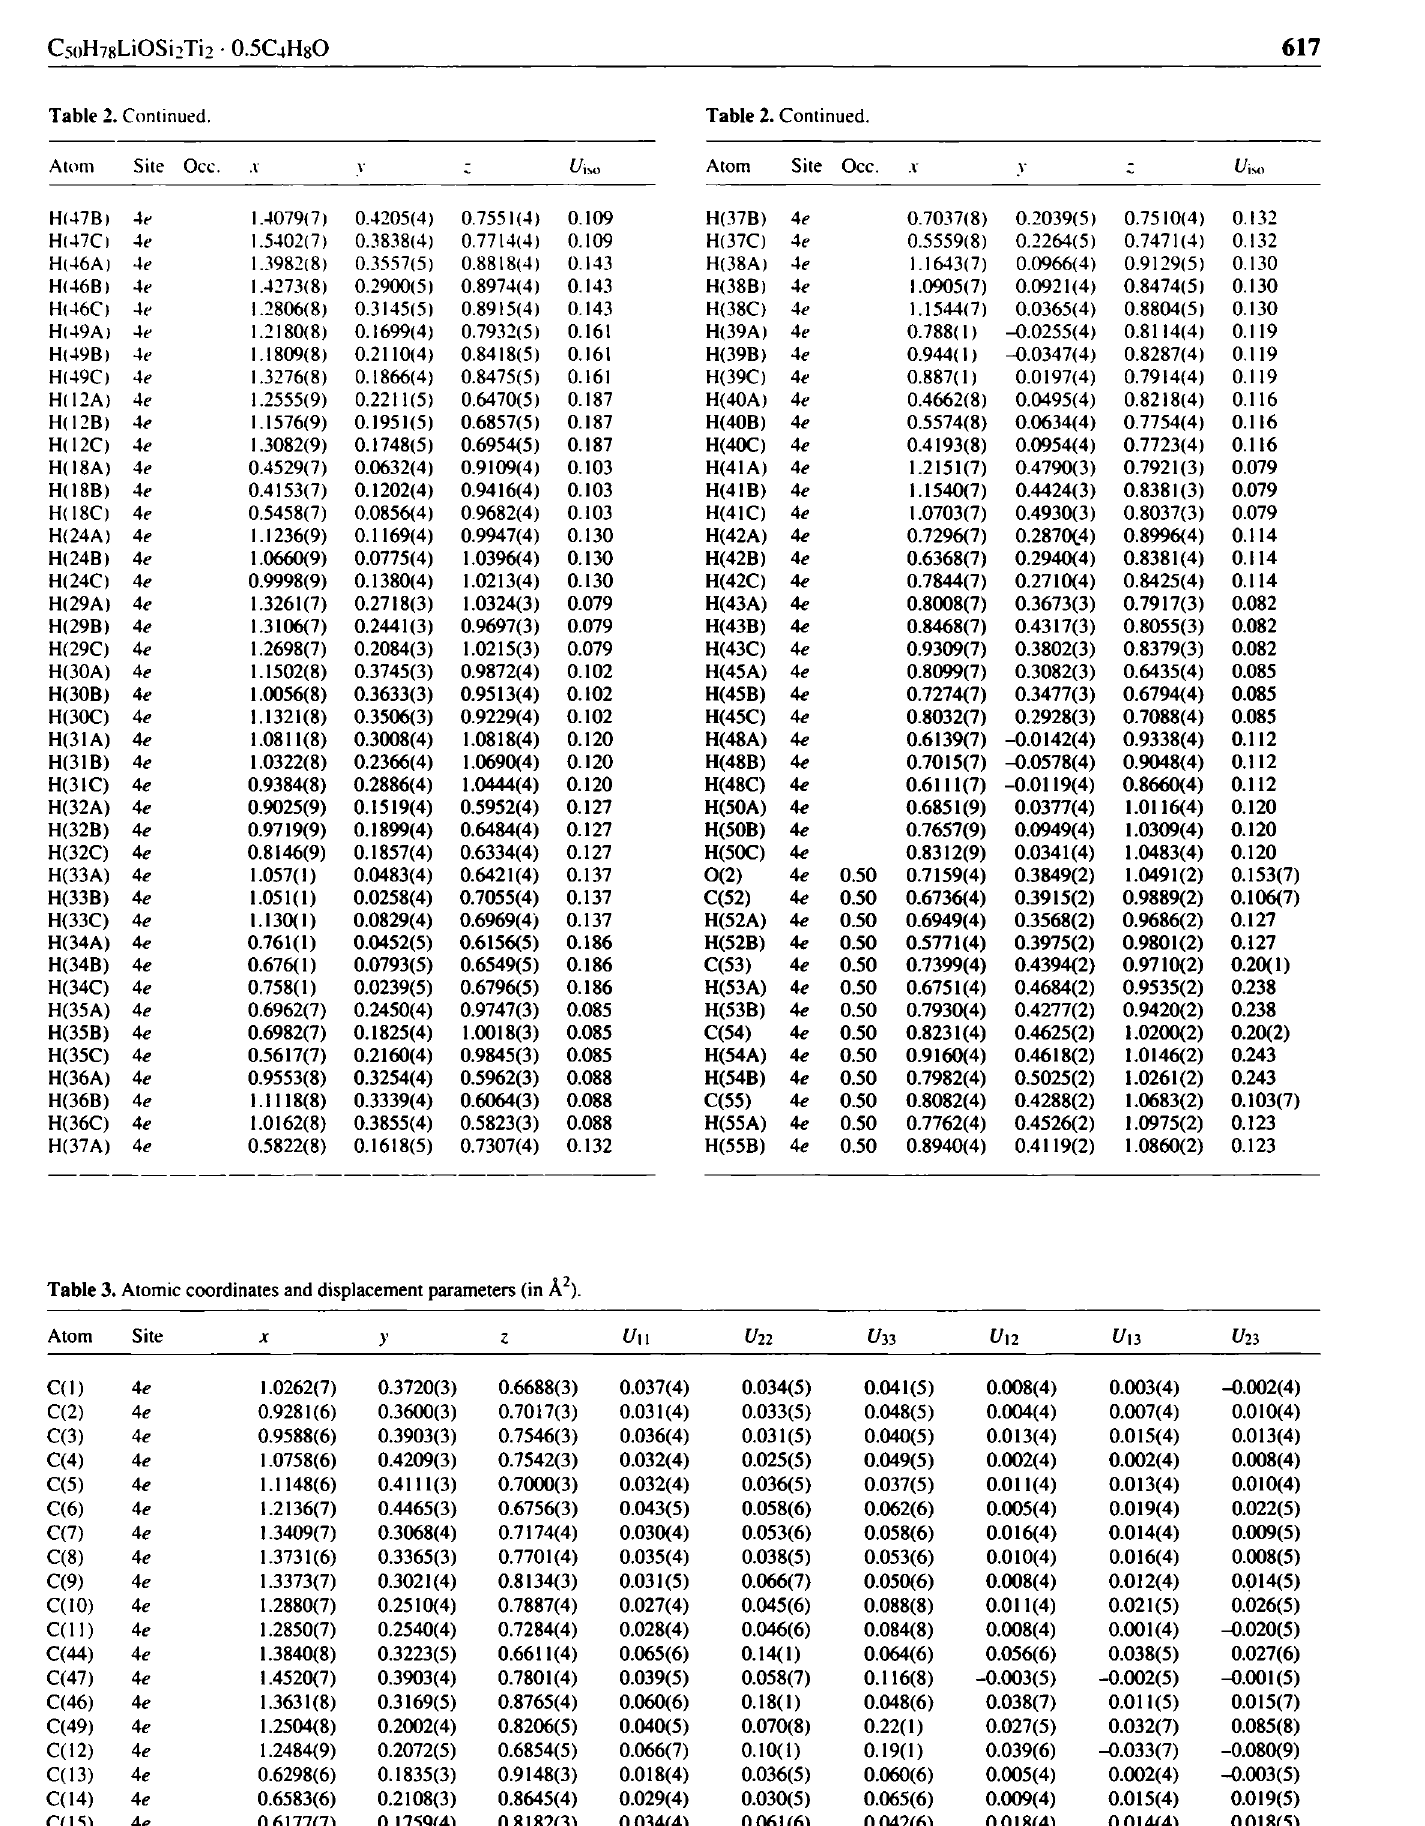
Table 3. Atomic coordinates and displacement parameters (in Ä 2